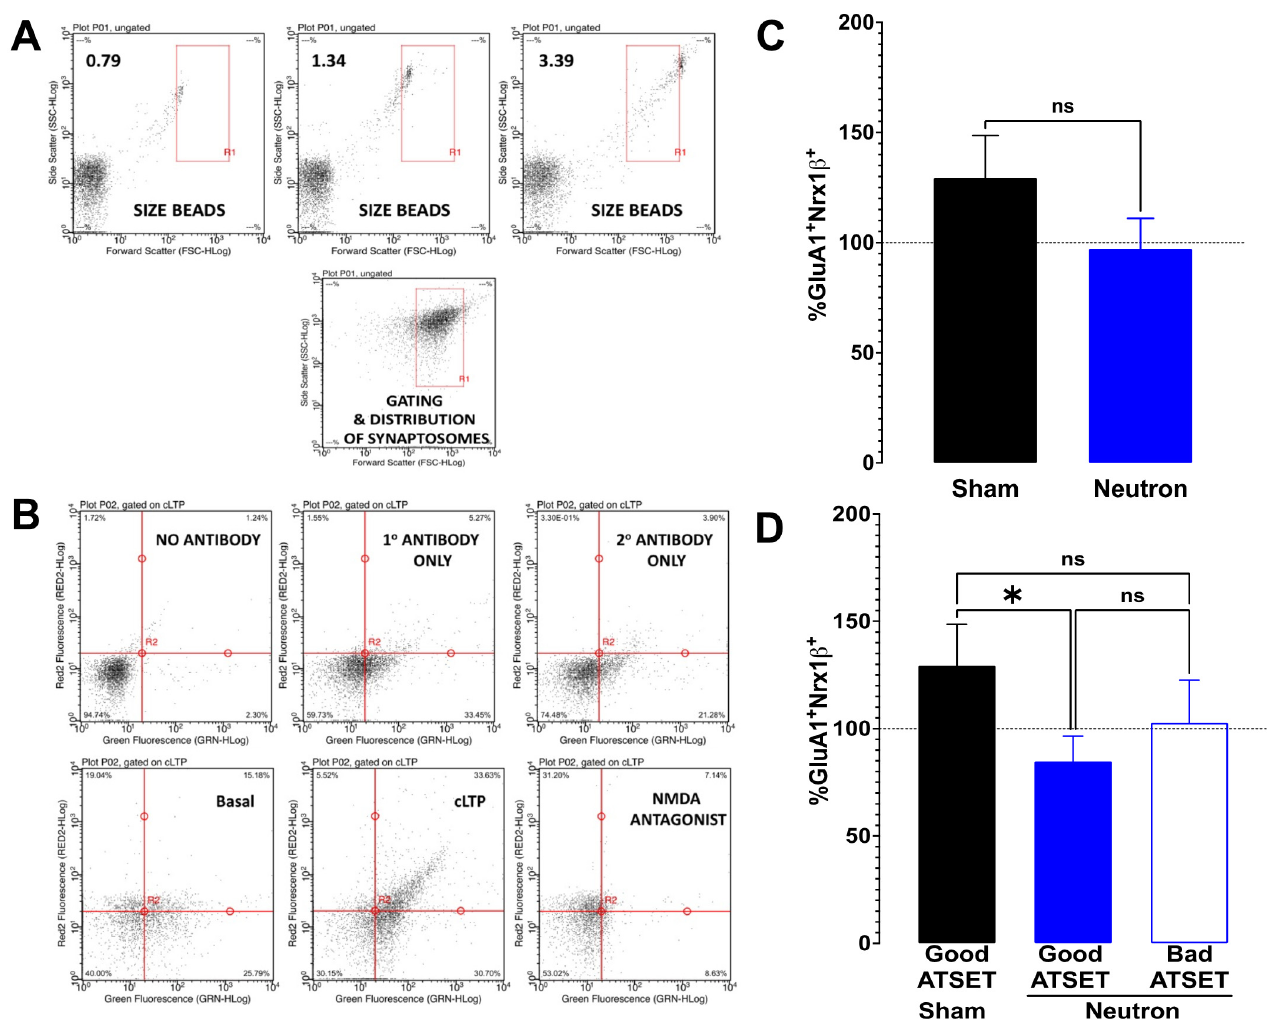
Figure 6. Fluorescence single synaptosome long-term potentiation (FASS-LTP) in chronic low-dose neutron irradiated rats. In order to estimate the functional status of the glutamate neurotransmission, hippocampal crude synaptosomal fractions were obtained from rats that were exposed chronic low dose neutron irradiation (black bars) and compared with age-matched sham controls (blue bars). ( A ) Representative forward scatter (FSC-HLog, x-axis) vs. side scatter (SSC-HLog, y-axis) dot plot showing the size–complexity profile of gated particles (inside R1 rectangle, size-gated synaptosomes). FSC–SSC dot plots using 0.79, 1.34 & 3.39 μ m calibrated beads. ( B ) Representative plots showing the profile of scatter under different conditions. The numbers used in the estimation of cLTP are the upper right (UR) quadrant, which is showing (in%), the number of closely associated GluA1 + Nrx1 β + particles gated to the synaptosomal size in that quadrant. Along the y-axis is the far-red fluorescence while along the x-axis is the green fluorescence that are couple to GluA1 and Nrx1 β , respectively. The lower left quadrant represents the particles that do not show any appreciable association between the two proteins, while the lower right shows the particles scattered by Nrx1 β and the upper left shows GluA1. Appreciable numbers of GluA1 + Nrx1 β + scatter in the UR quadrant is only seen in the panel labeled “cLTP (chemically induced LTP)”. The panels that contain either no antibody or any one of the antibodies or extracellular buffer (basal) do not show a significant increase. The use of AP5, the NMDA antagonist, prevents the cLTP and is an effective negative control used in validating the response. ( C ) Potentiation levels in sham animals as a function of the basal response is shown in black bars (129.4 ± 19.18, n = 10) while the irradiated group is shown in blue bars (97.86 ± 13.87, n = 21); there is no significant difference between the two ( p = 0.1917, unpaired t-test) ( D ) Upon separation of the irradiated groups into good performers vs. bad performers in the ATSET behavioral paradigm, the good performers (filled blue bars, 86.24 ± 13.45, n = 7) show a significant difference (* p = 0.044) compared to the sham, but the bad performers (clear blue bars, 102.7 ± 19.88, n = 14) do not show any significant difference to either groups. Collectively these data suggest that LTP within the HPC of rats exposed to neutrons is reduced relative to that observed in sham rats, and that neutron exposed rats that had